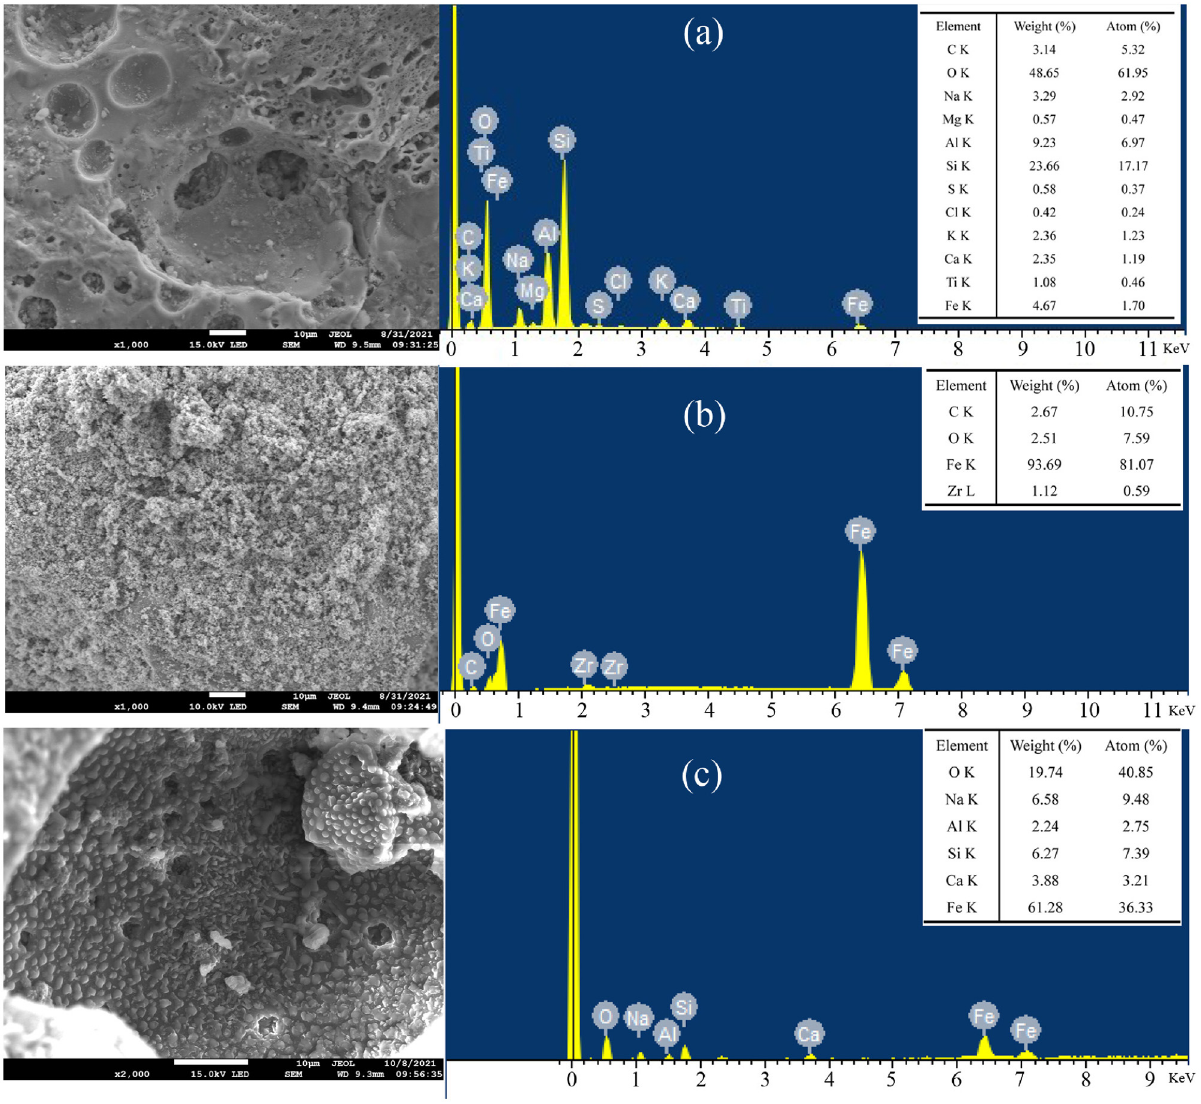
Figure 3: SEM - EDS results of ( a ) ceramsite, ( b ) ceramsite - supported nZVI, and ( c ) exhausted ceramsite - supported